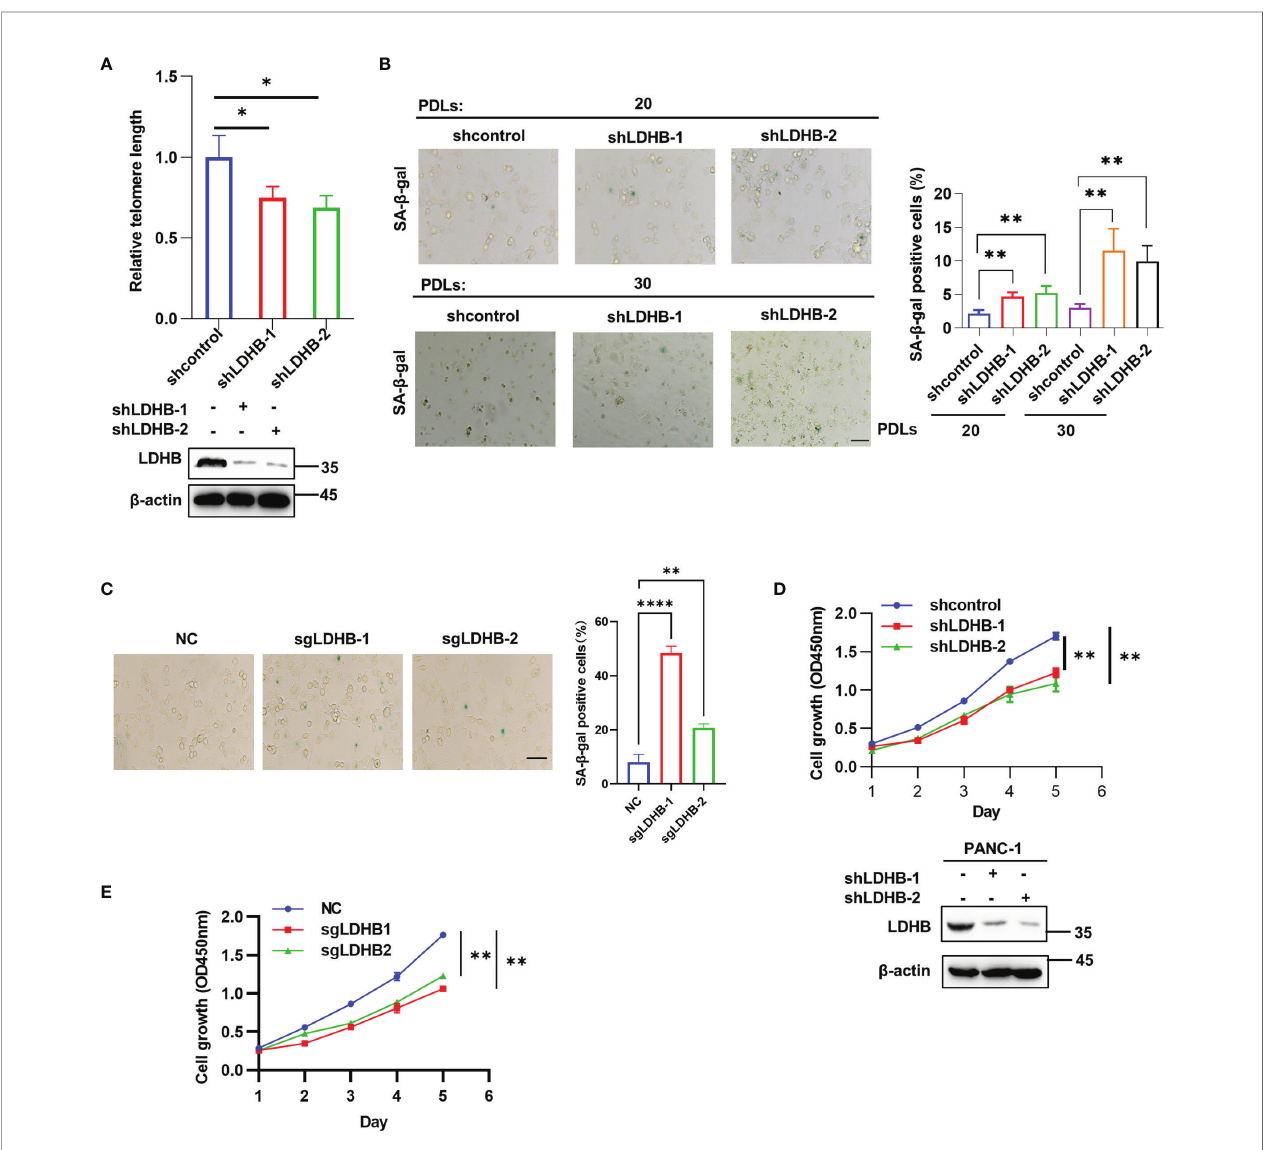
FIGURE 3 | LDHB regulates telomere length and cell senescence in pancreatic cancer cells. (A) The telomere length of two PANC-1 single clone cells stably expressing shRNA of LDHB at 20 population doublings (PDLs) was detected by qPCR. The expression of LDHB were detected by western blot analysis. (B) Proportion of senescent cells of monoclonal PANC-1 cells stably expressing shRNA of LDHB at 20 PDLs and 30 PDLs were detected by SA- b -Gal staining. The percentage of senescence positive cells in each group from fi ve randomly chosen fi elds was calculated. Scale bars, 50 m m. (C) PANC-1 cells stably expression LDHB sgRNAs were cultured for 25 PDLs and SA- b -Gal staining was performed. Scale bars, 50 m m. (D) Proliferation of PANC-1 shLDHB monoclonal cells at 20 PDLs was detected by CCK-8 assay. The expression of LDHB was detected by western blot analysis. (E) PANC-1 cells stably expression LDHB sgRNAs were cultured for 25 PDLs and CCK-8 assay was performed. Data are representative of three independent experiments (mean ± SD of three biological replicates (A, D, E) or three technical replicates (B, C) . * P< 0.05, ** P< 0.01, **** P<